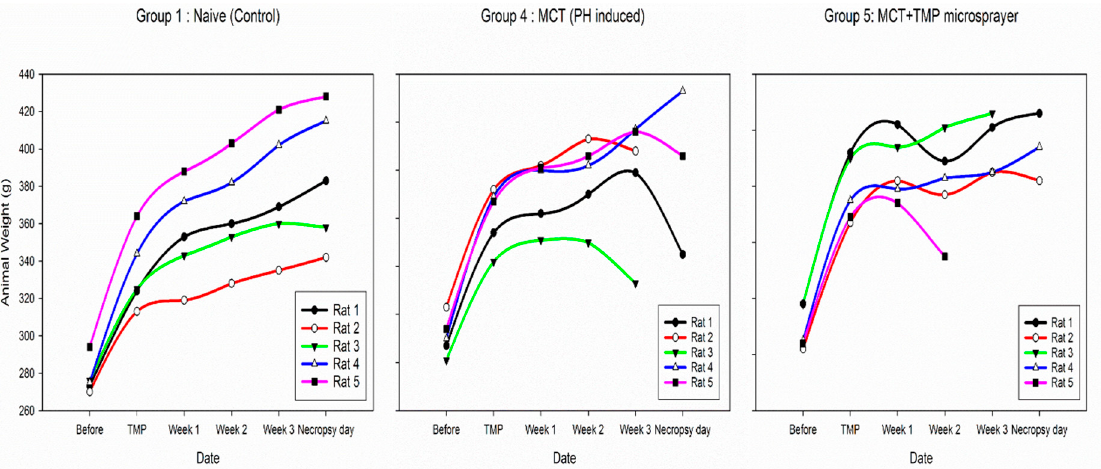
Figure 10. Body weights of rats measured weekly for Groups 1, 4 and 5 from Microsprayer ® Aerosolizer (liquid aerosol) study.